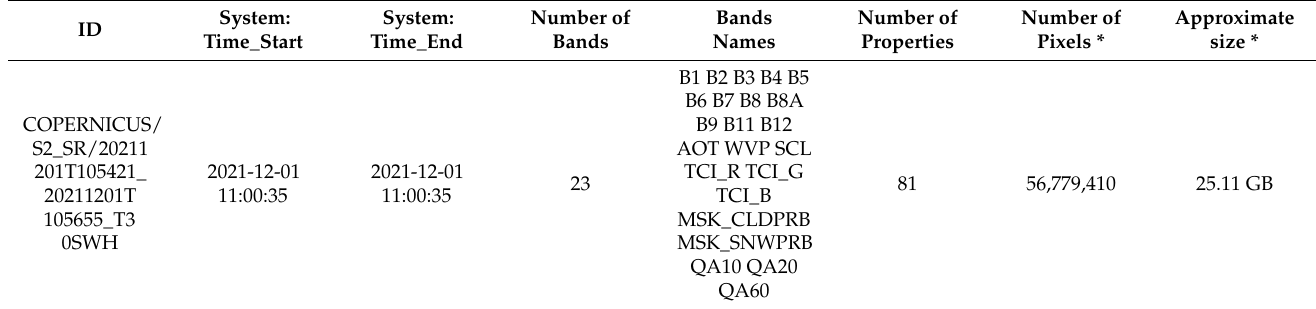
Table 10. Earth Engine COPERNICUS/S2_SR mosaic clipped on (02_Camp_Altiplano)—Image